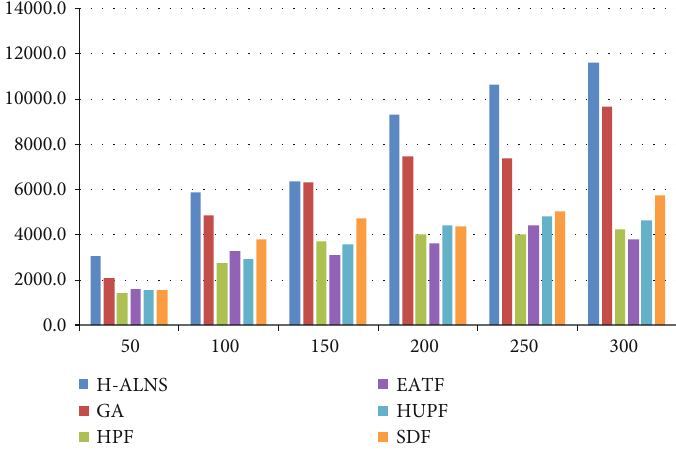
Figure 5: Average pro fi t performance.